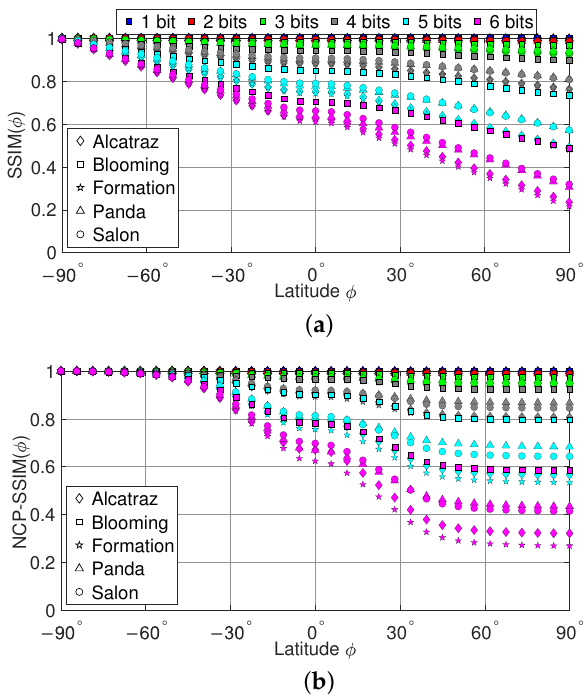
Figure 19. Visual quality of viewing direction based LSB data hiding in the latitude: ( a ) SSIM( φ ), ( b ) NCP-SSIM( φ ).